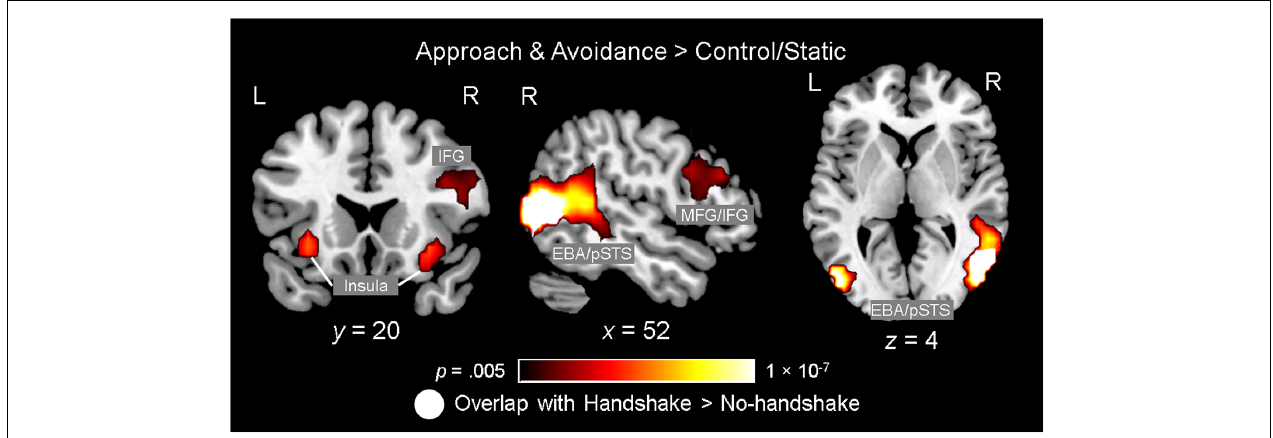
FIGURE 3 | Observing ingroup and outgroup dynamic social interactions and handshakes engages the neural networks involved in action observation and social cognition. Observing approach and avoidance compared to static behaviors was associated with increased activity in a network of brain regions previously implicated in action observation and social cognition, including the lateral prefrontal cortex (PFC) regions [e.g., middle/inferior frontal gyri (MFG/IFG)], insula, left inferior parietal lobule (not shown), and bilateral temporo-occipital regions covering broader areas including the posterior superior temporal sulcus (pSTS) and extrastriate body area (EBA). Interestingly, an independent ANOVA examining the effect of observing handshakes also identified the right pSTS/EBA area showing significant spatial overlap with this right temporo-occipital area. Activation maps identifying the regions showing the effect of observing approach/avoidance behaviors relative to control (gradient), and the right pSTS/EBA area also showing the effect of observing handshake (white), are overlaid on top of a high-resolution anatomical template image in the MNI